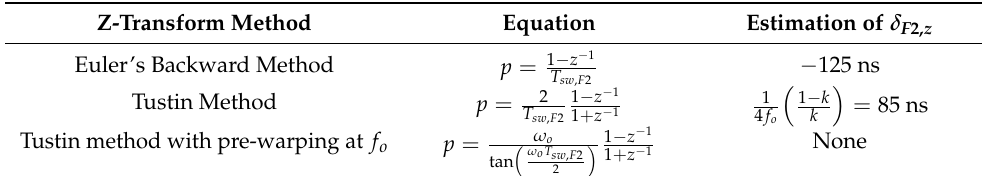
Table 2. Mains z-transforms and resulting time delays after 2nd order low-pass filter discretization. Z-Transform